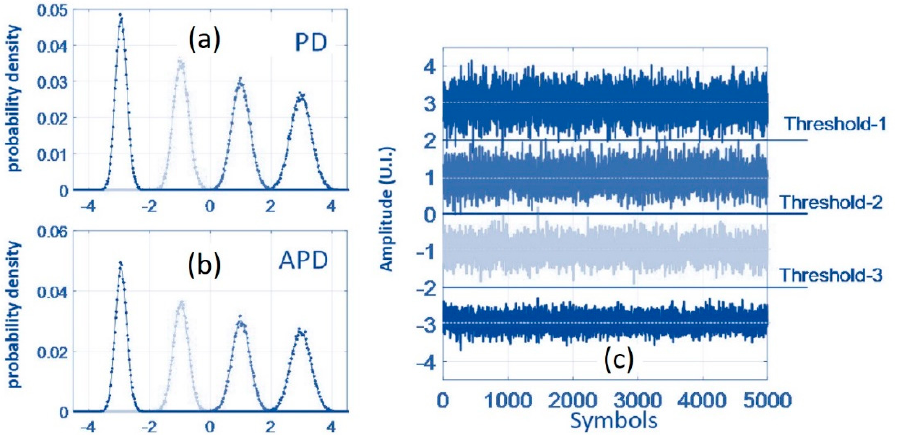
Figure 4. ( a ) The nonlinear probability density distributions of received PAM4 signal for ( a ) OA + PD, and ( b ) APD. ( c ) The waveform of received PAM4 signal after APD (reprinted from [63] with permission from authors).